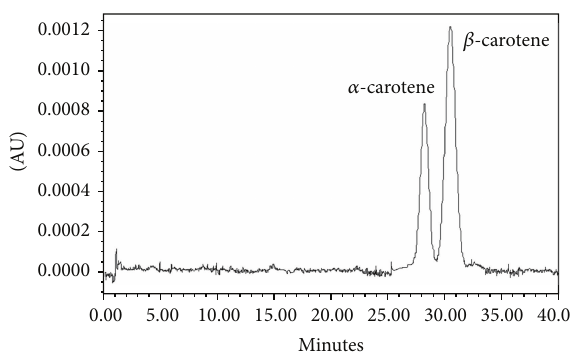
Figure 2: HPLC chromatogram of 𝛼 - and 𝛽 -carotene.